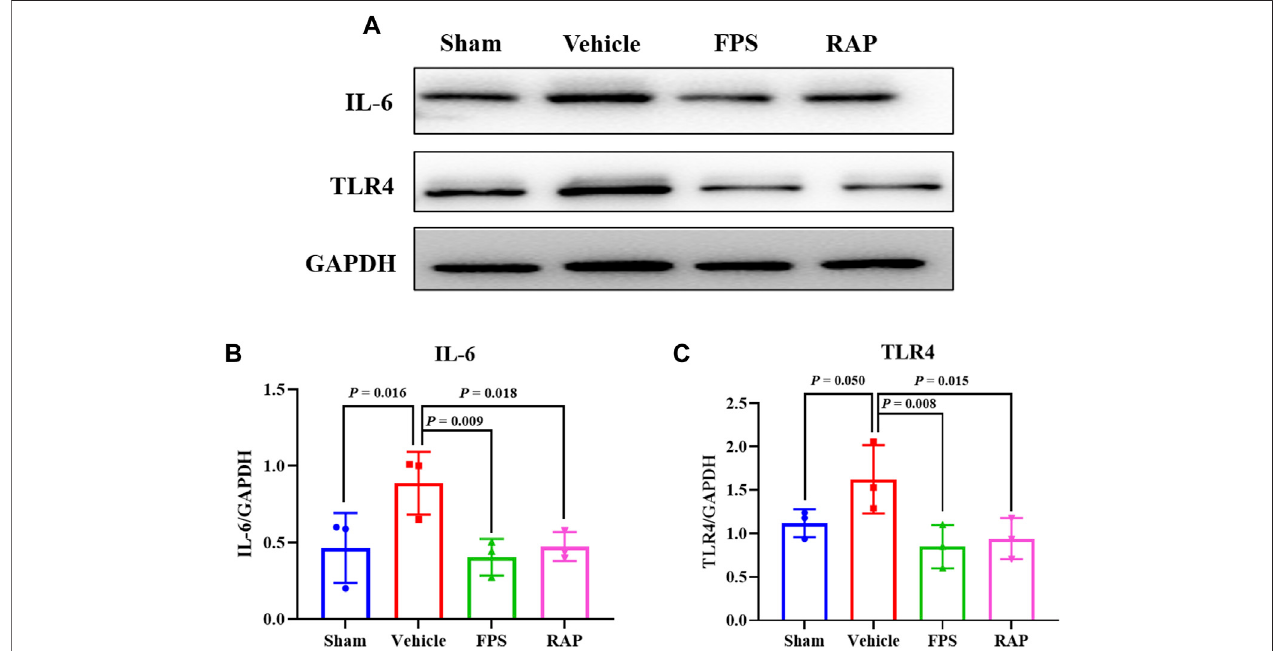
FIGURE6| EffectsofFPSandRAPontheexpressionlevelsofIL-6andTLR4 invivo . (A) TheWBanalysisofIL-6andTLR4inthediabetickidneys. (B,C) Therateof IL-6 and TLR4 to GAPDH, respectively. The data are expressed as the mean ± SD.